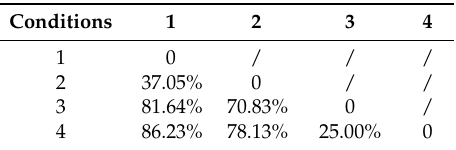
Table 7. The percentage increased in horizontal contrast of 4